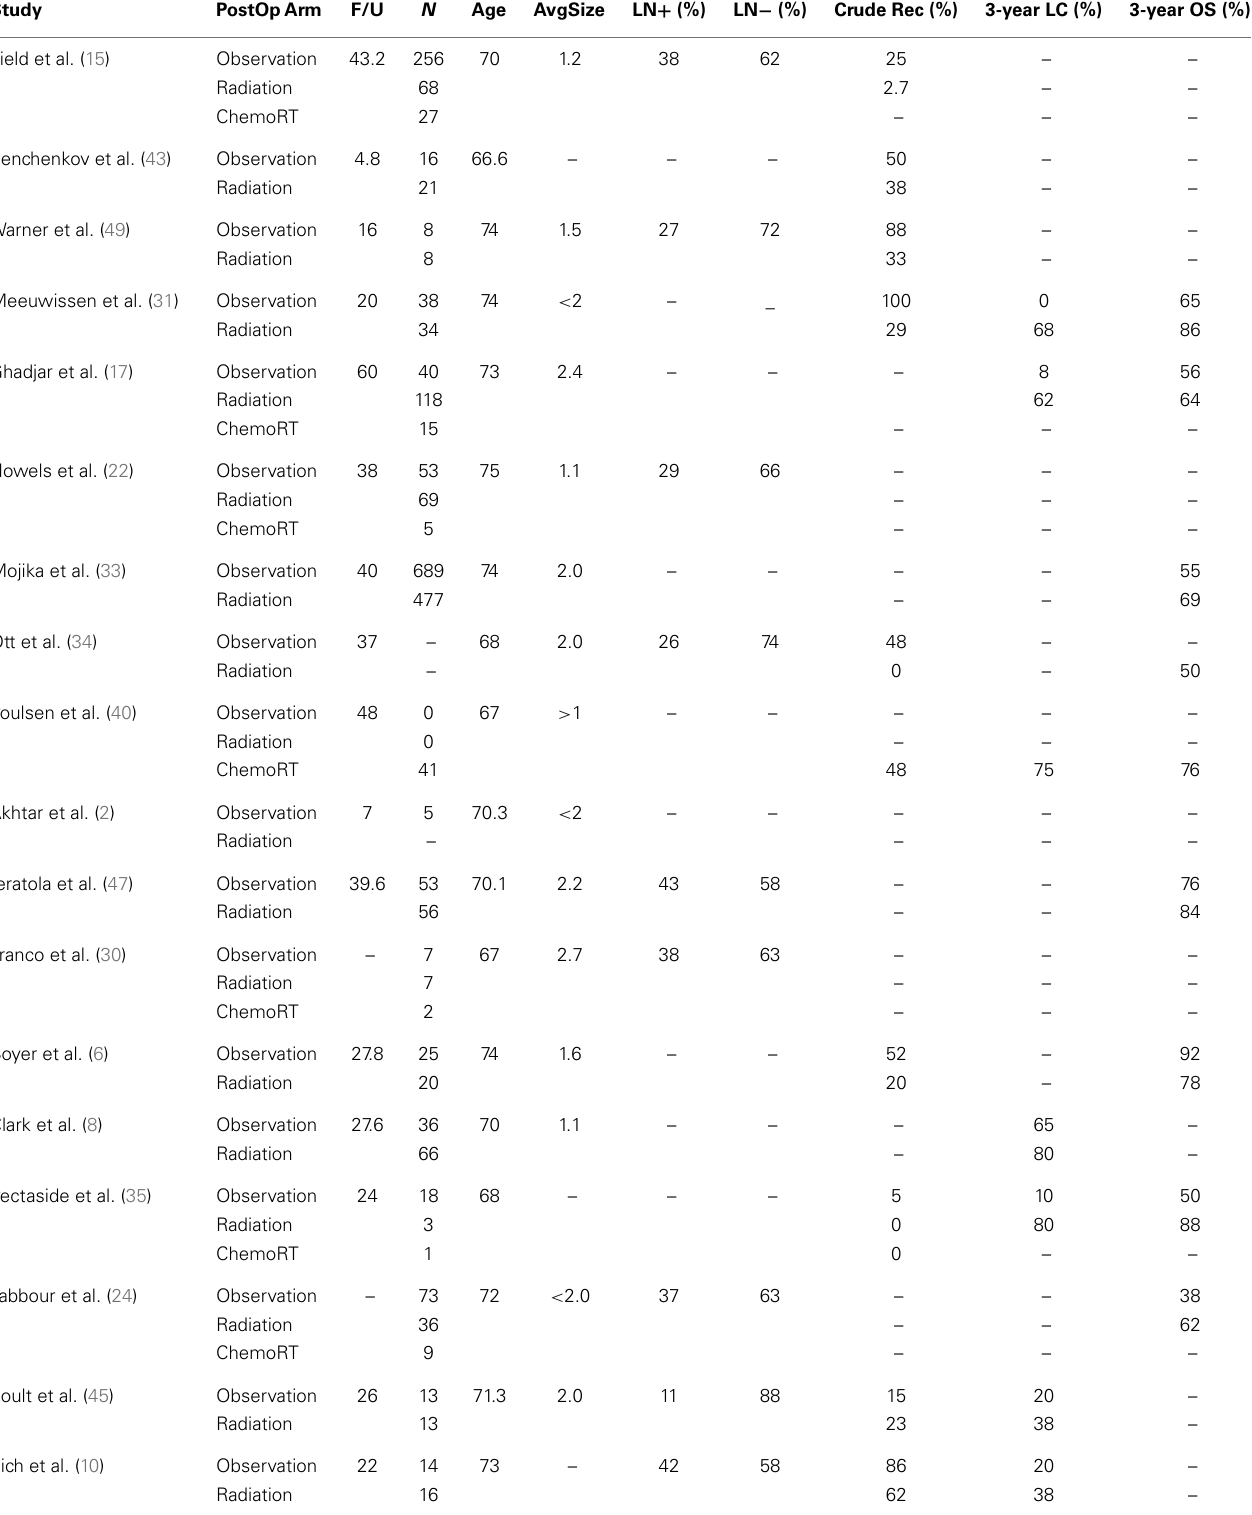
Table 4 | Summary of age, follow up, size, nodal status, and outcome across three treatment cohort from 34 original